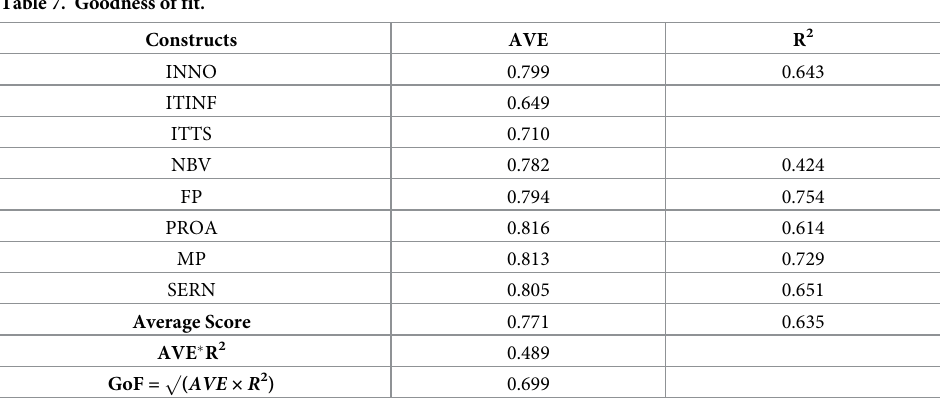
Table 7. Goodness of fit.